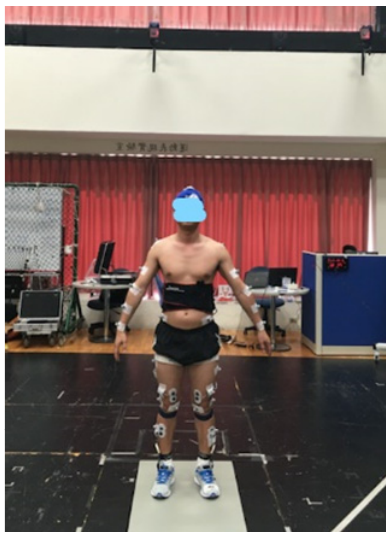
Figure 2. Experimental setup.